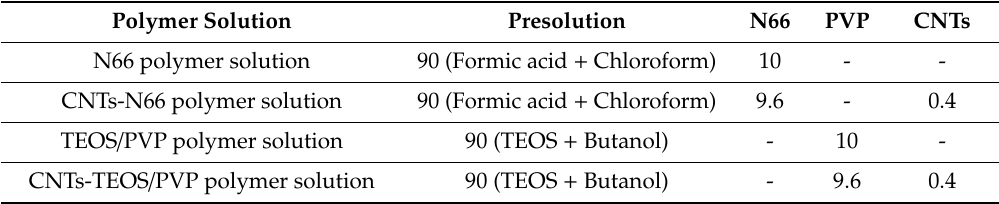
Table 2. Component proportions of polymer solutions by weight percent (%).